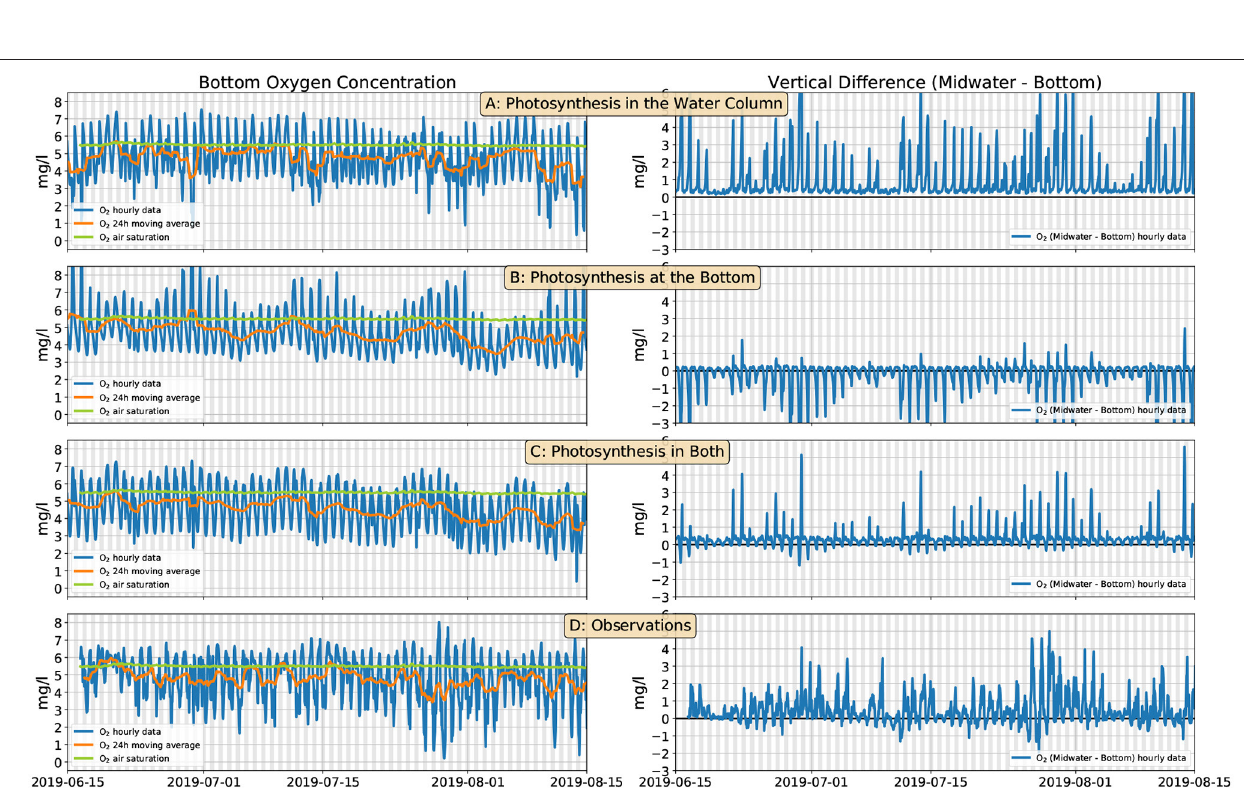
Frontiers in Marine Science |